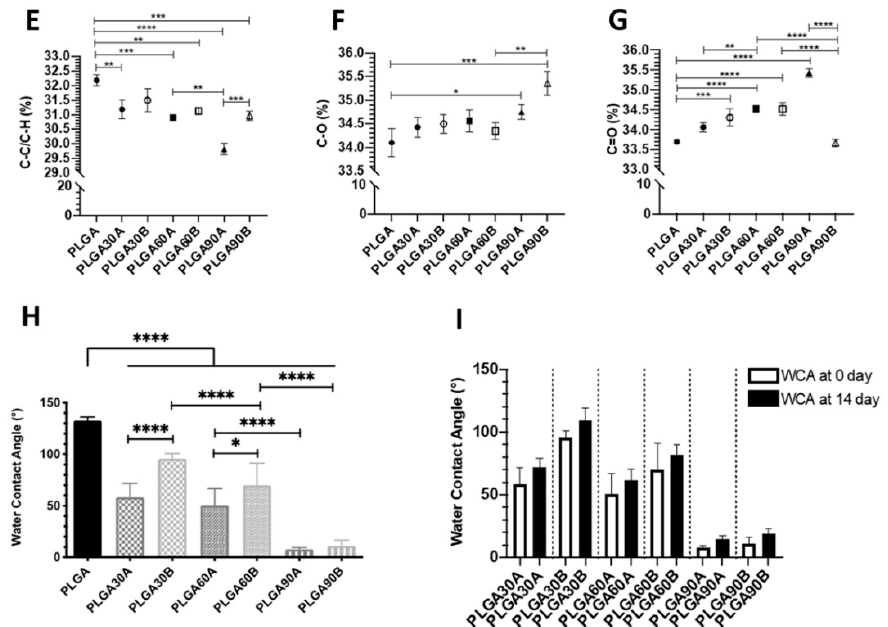
Figure 3. ( A ) The deconvoluted C1s XPS spectra of the untreated and CAP treated electrospun PLGA microfibers with different process’ parameters. Atomic content of ( B ) carbon, ( C ) oxygen and ( D ) O/C ratio obtained by XPS technique for the untreated and CAP treated PLGA microfibers. Bonds percentages of the C1s deconvolution regarding ( E ) C-C/C-H, ( F ) C-O and ( G ) C=O obtained by XPS technique for the untreated and CAP treated PLGA microfibers. ( H ) Changes in the Water contact angles (WCA) between untreated and CAP treated PLGA microfibers by varying the exposure time and working distance. ( I ) Ageing analysis to assess the stability of the CAP treated PLGA microfibers between day 0 and day 14. *, **, ***, and **** Statistically significant between the groups ( p < 0.05, p < 0.01, p < 0.001, and p < 0.0001, respectively).